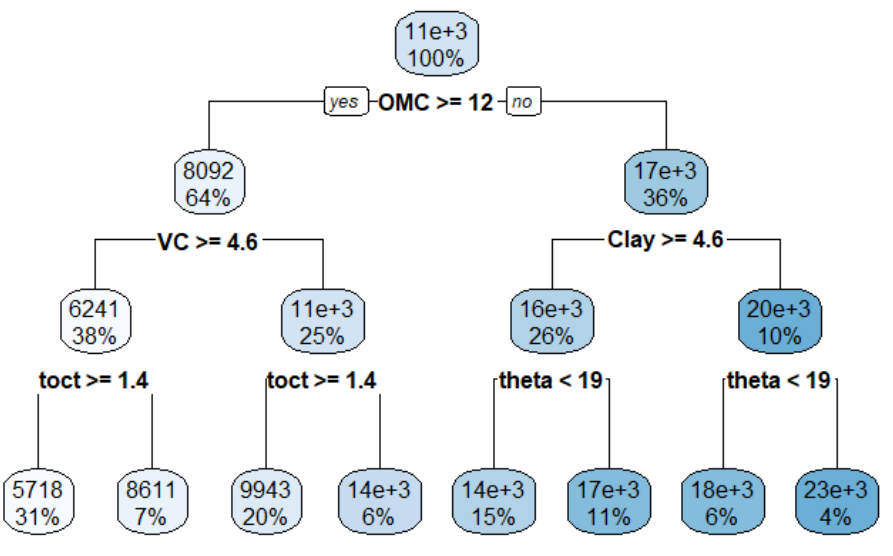
Figure 5. Regression tree model.